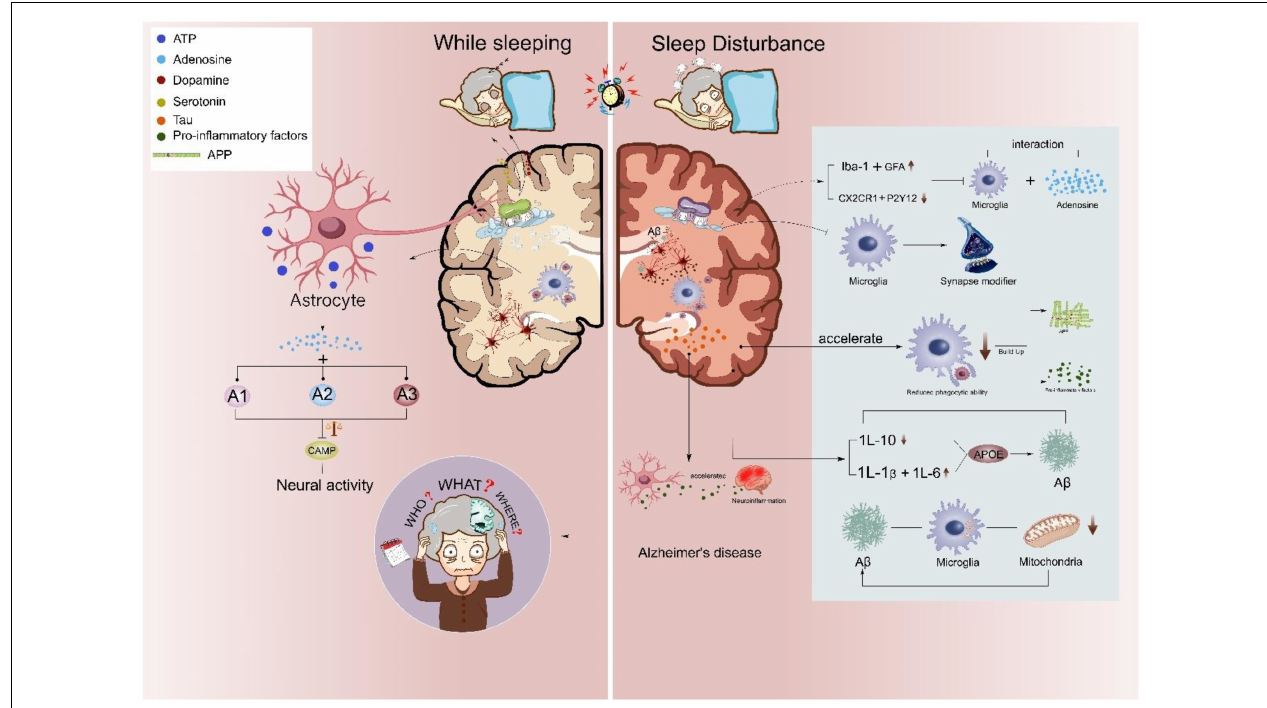
FIGURE 2 | Astrocyte and microglial roles in sleep disturbance linked Alzheimer’s disease. Sleep disturbances accelerate the neuropathological changes of AD. During normal sleep/wake rhythm, astrocytic adenosinergic A1, A2, and A3 inhibit neural overactivation, while sleep disturbance attenuates microglial CX3CR1 and P2Y12 further inhibiting the phagocytic capacity of microglia. Abnormal sleep rhythms also promote microglial Iba-1 and astrocytic glial fibrillary acidic protein (GFAP) and increase microglia-mediated proinflammatory releases, such as IL-1b, IL-6, IL-10, and TNF α . Activated inflammatory status further induces microglial A β aggregation and microglial-accumulated tau in